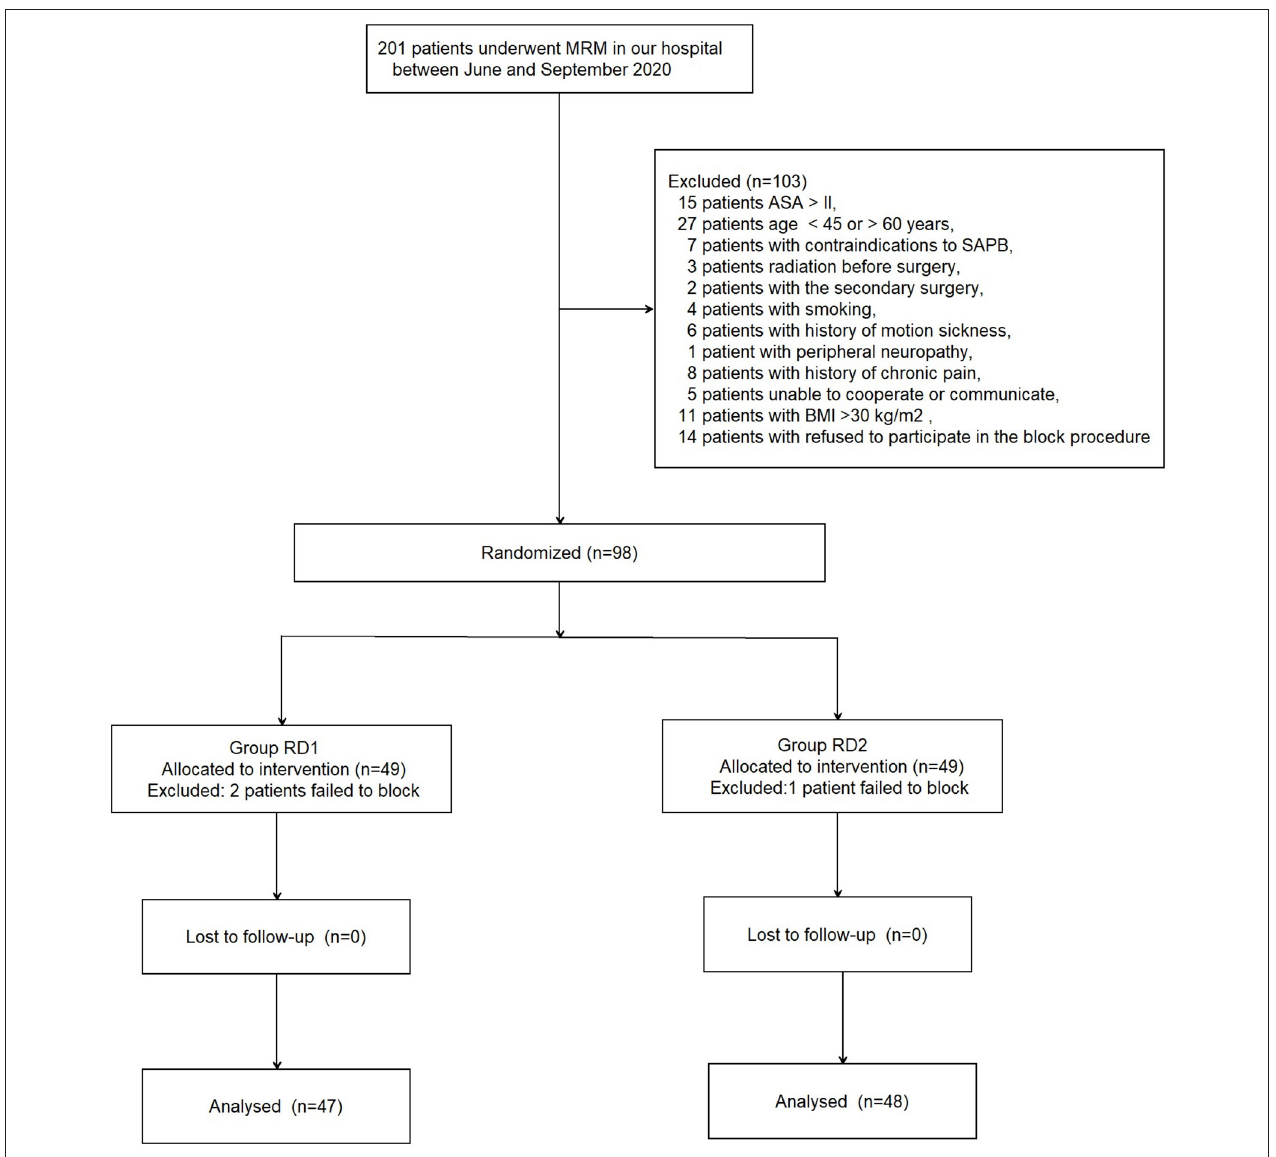
FIGURE 1 | Flowchart showing patient